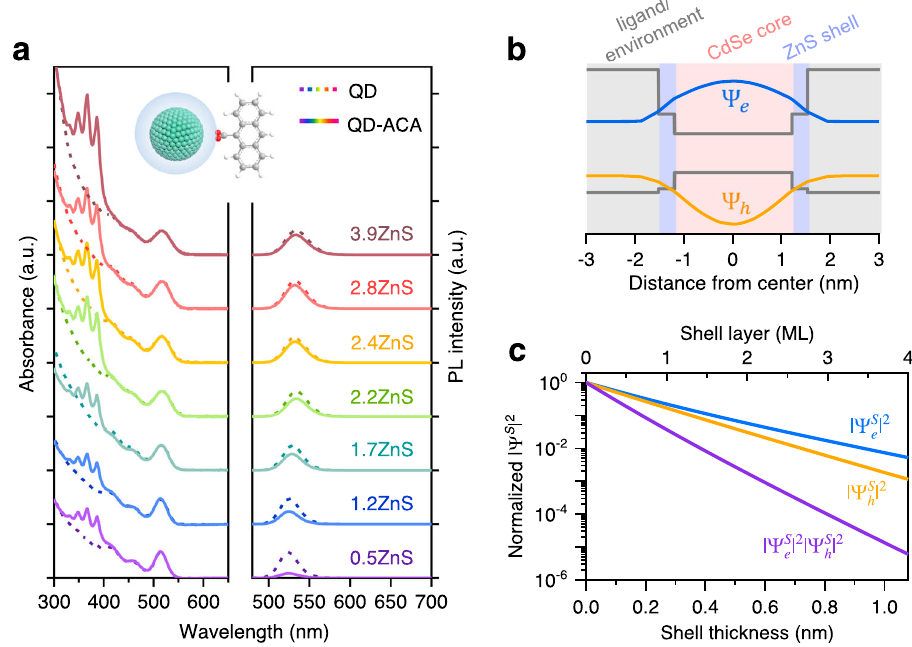
Fig. 2 Wavefunction control in core/shell QDs. a Absorption (left) and PL (right) spectra of CdSe/ZnS quantum dots (QDs) with varying shell thicknesses (dashed lines). Similar plots for QD-ACA (9-anthracene carboxylic acid) complexes are in solid lines. The samples are labeled as CdSe/ x ZnS with x representing the number of ZnS monolayers. b Electron (blue) and hole (orange) wavefunction distributions in the lowest excited state of CdSe/1.2ZnS QDs calculated from a single-band effective mass approximation (EMA) model in the single-particle representation. The band alignments are shown by the gray solid lines. c Squared electron (blue) and hole (orange) wavefunctions and their product (purple) on CdSe/ZnS QD surface as a function of shell